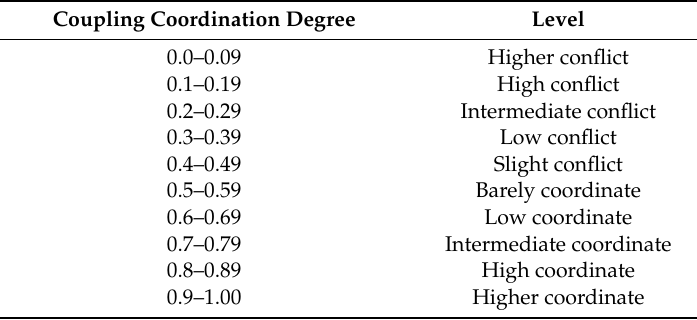
Table 2. Classification standard of the coupling coordination